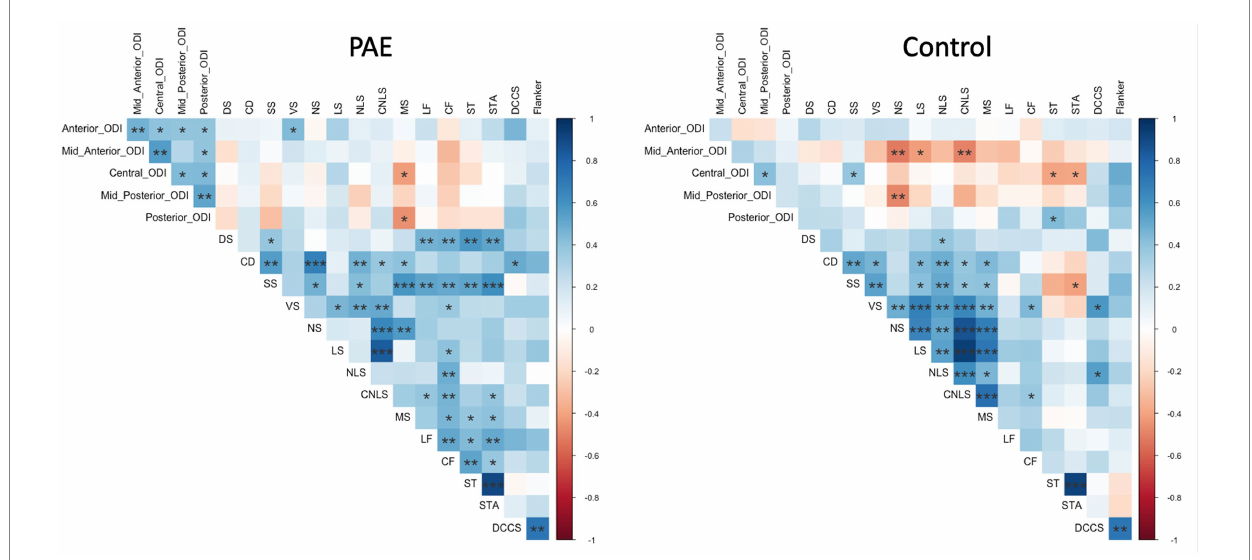
FIGURE 5 Correlation between SPC in corpus callosum ODI and executive function performance. DS, Digit Span; CD, Coding; SS, Symbol Search; VS , Visual Scanning; NS, Number Sequencing; LS, Letter Sequencing; NLS, Number-Letter Sequencing; CNLS, Combined Number-Letter Sequencing; MS, Motor Speed; LF, Letter Fluency; CF , Category Fluency; ST, Switching Total; STA, Switching Total Accuracy; DCCS, Dimensional Change Card Sort; blue shaded cells indicate positive correlations; red shaded cells indicate negative correlations. * p < 0.05, ** p < 0.01, *** p <